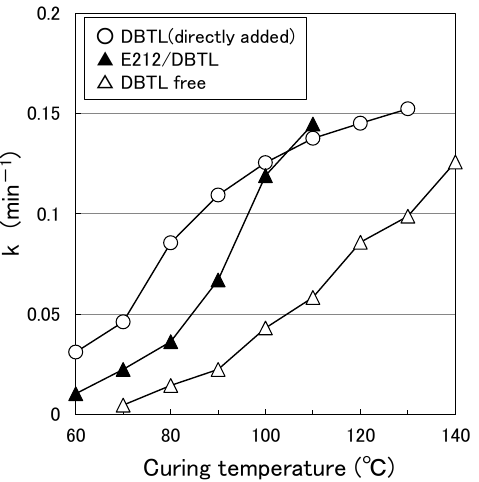
Figure 3. Relationship between k and curing temperature (surfactant: E-212).